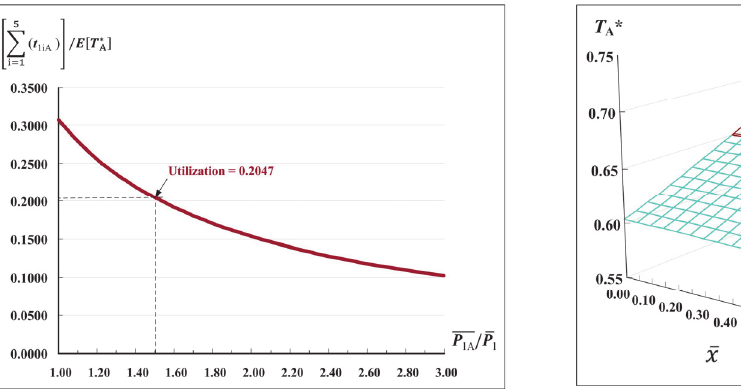
Fig. 7. Impact of changes in utilization